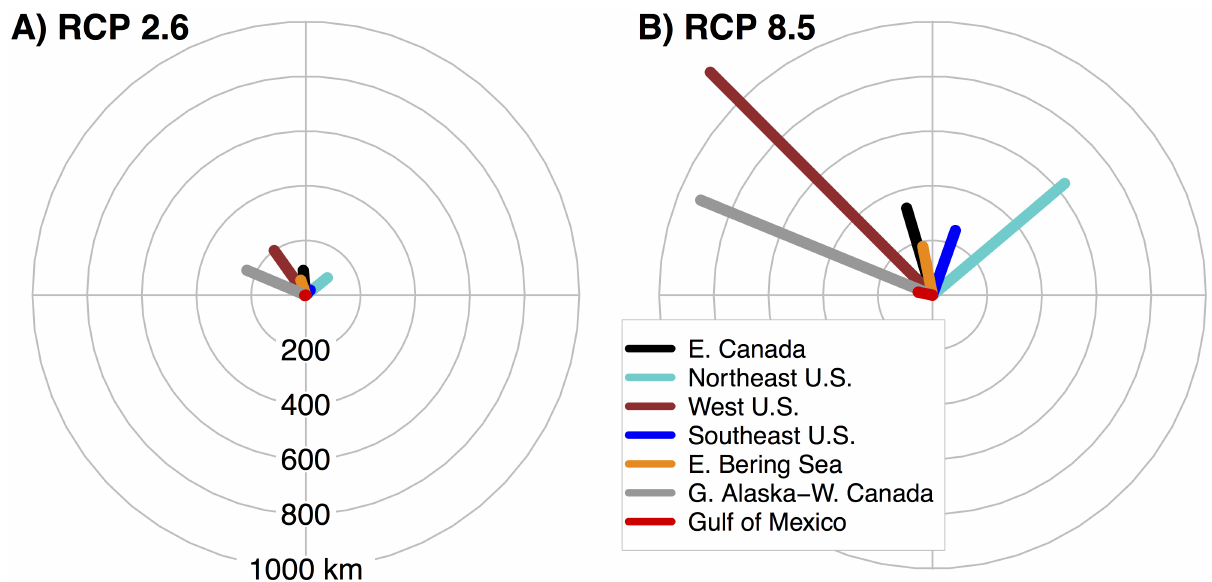
Fig 5. Regional difference in projected distribution shifts. Mean direction and magnitude of projected centroid shifts over the 21 st century for low uncertainty species originating from seven regions of the North American shelf for (A) RCP 2.6 and (B) RCP 8.5.